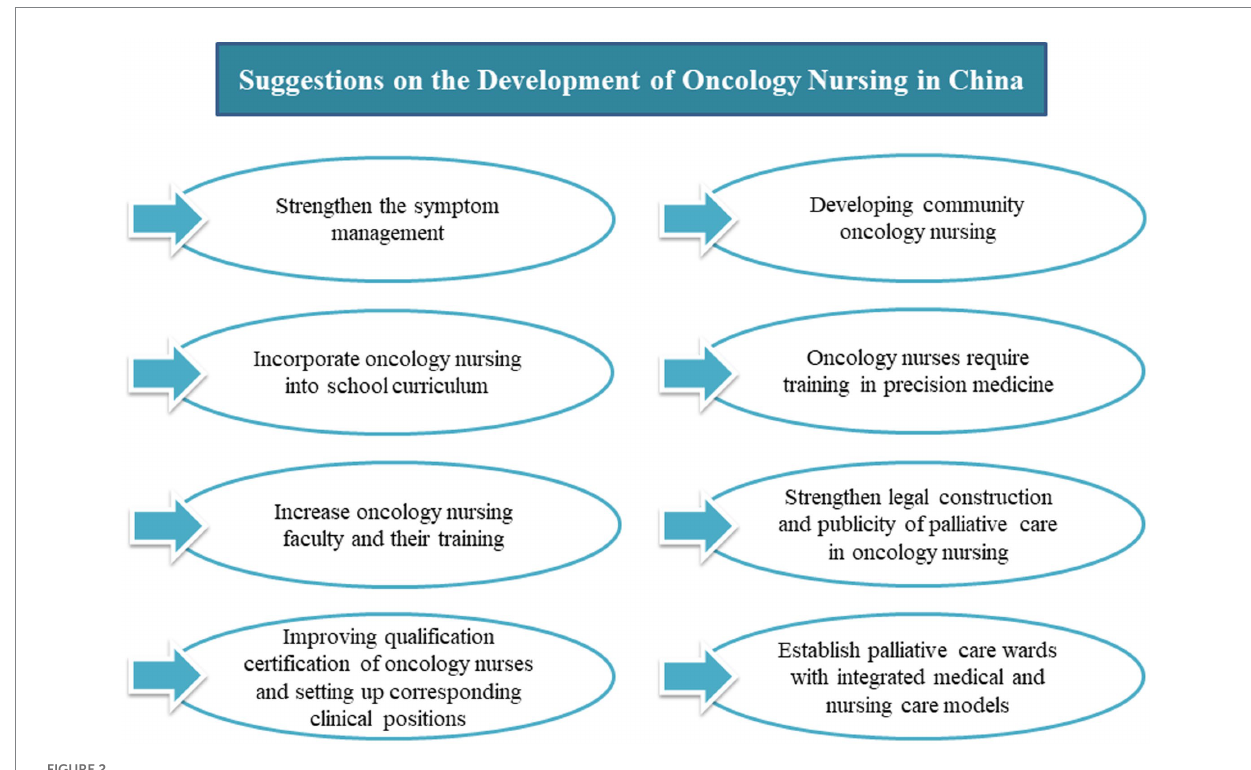
FIGURE 2 Suggestions on the development of oncology nursing in